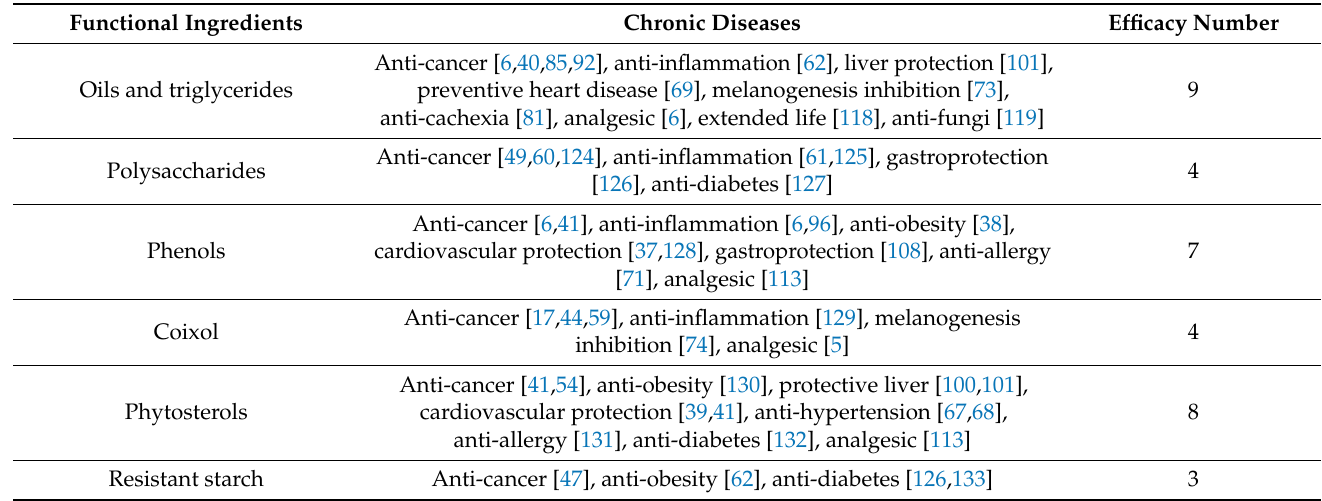
Table 5. Relationship between functional components of adlay and chronic